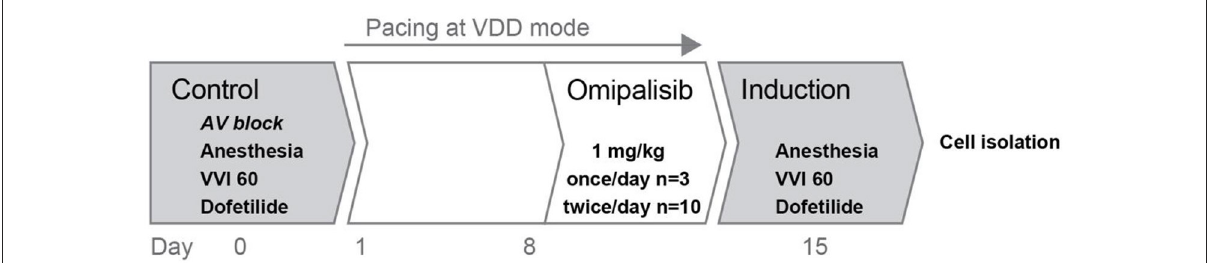
FIGURE1 Overview of the experimental protocol. Two experiments were performed in series: control and induction, before and after omipalisib treatment to examine the potential proarrhythmic effect of omipalisib in the AV block dog model.